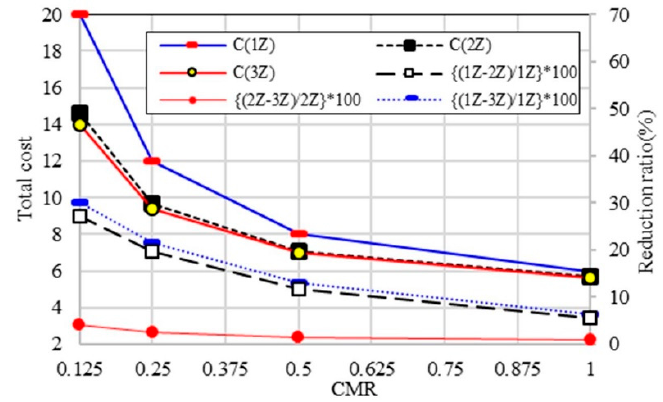
Figure 9. Total cost for various CMR.